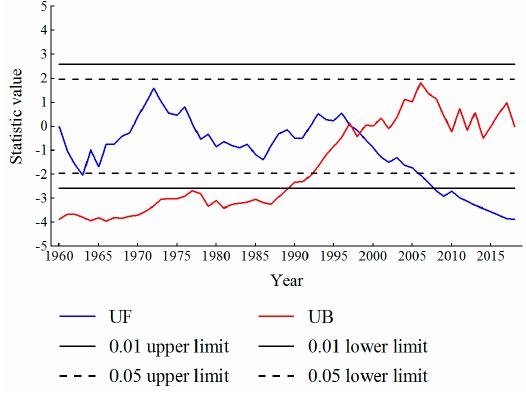
Figure 9. M-K-S test results of the annual SPEI.